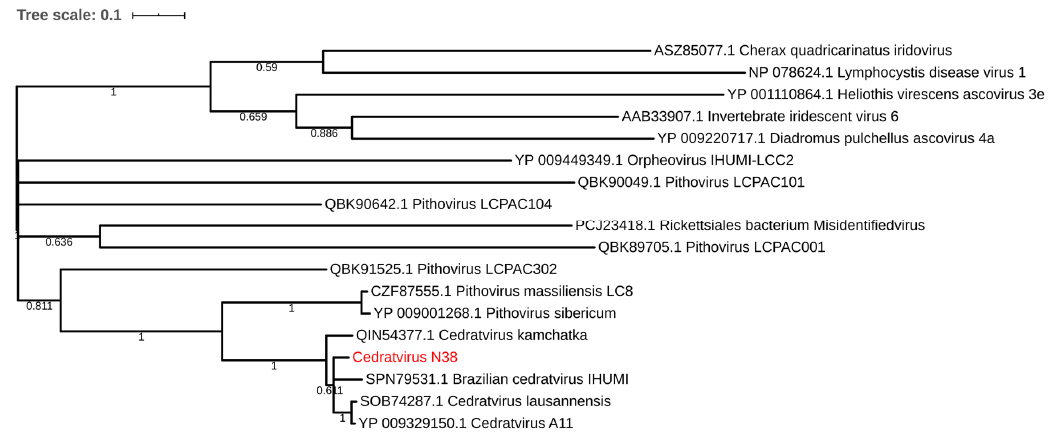
Figure 3. Maximum-likelihood tree based on the RNA polymerase subunit 1. Branch values lower than a bootstrap value of 0.5 were deleted.